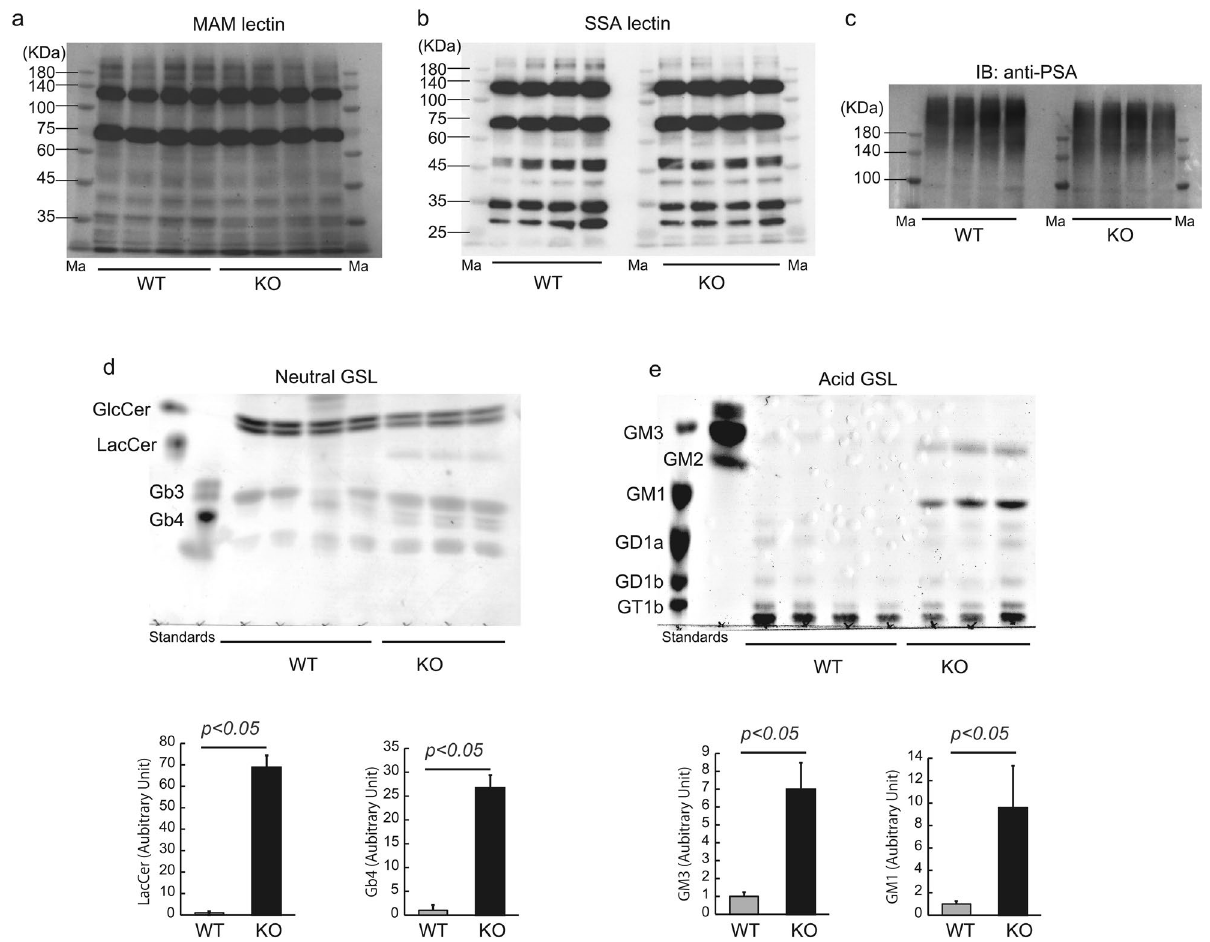
Figure 7. Alteration of glycoconjugates patterns in Neu1-KO zebrafish. ( a – c ) Lysates of zebrafish brains were applied for lectin and western blotting. ( a ) MAM lectin. ( b ) SSA lectin. ( c ) Anti-PSA immunoblotting. Ma, Molecular marker. ( d , e ) GSLs were extracted from zebrafish brains and fractionated into neutral and acid fractions. Two fractions were applied for thin layer chromatography and GSLs were detected using orcinol- H 2 SO 4 . Neutral ( d ) and acid fraction ( e ) of GSLs. Results are shown as means ± standard deviation. All values were compared using Mann–Whitney U